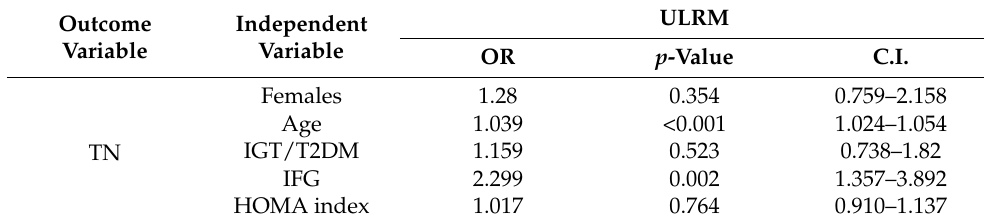
Table 3. Univariable logistic regression models (ULRM) with TNs as the main outcome.